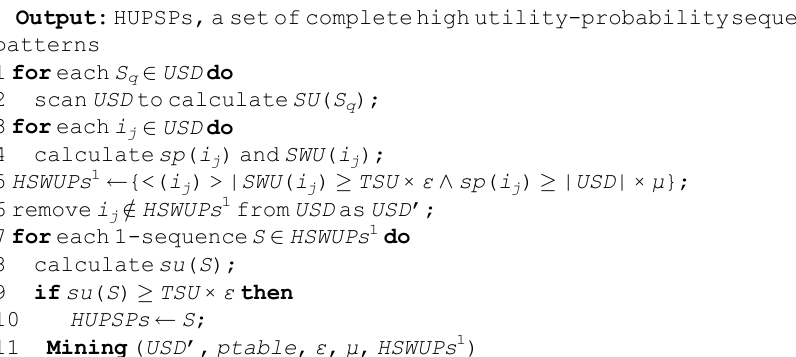
Algorithm 2: Projection HUSPM, P-HUSPM